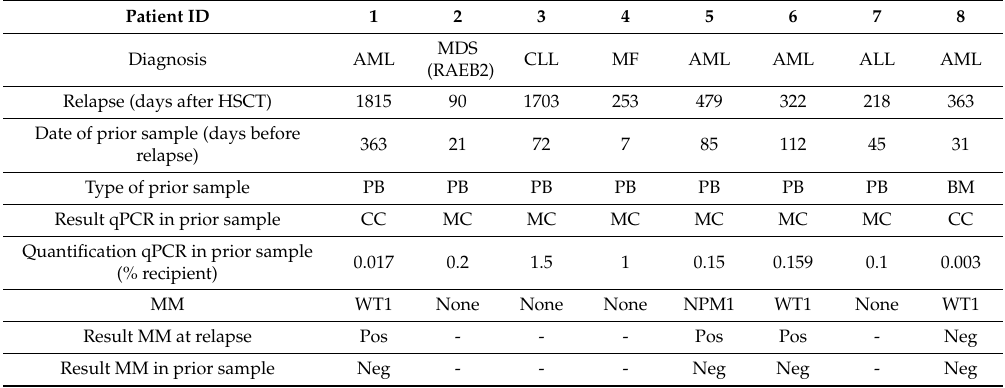
Table 2. Summary of results of chimerism quantification by qPCR in relapsed patients. AML: Acute Myeloid Leukemia; MDS: Myelodysplastic Syndrome; RAEB2: Refractory Anemia with Excess Blasts type 2; CLL: Chronic Lymphocytic Leukemia; MF: Myelofibrosis; ALL: Acute Lymphoblastic